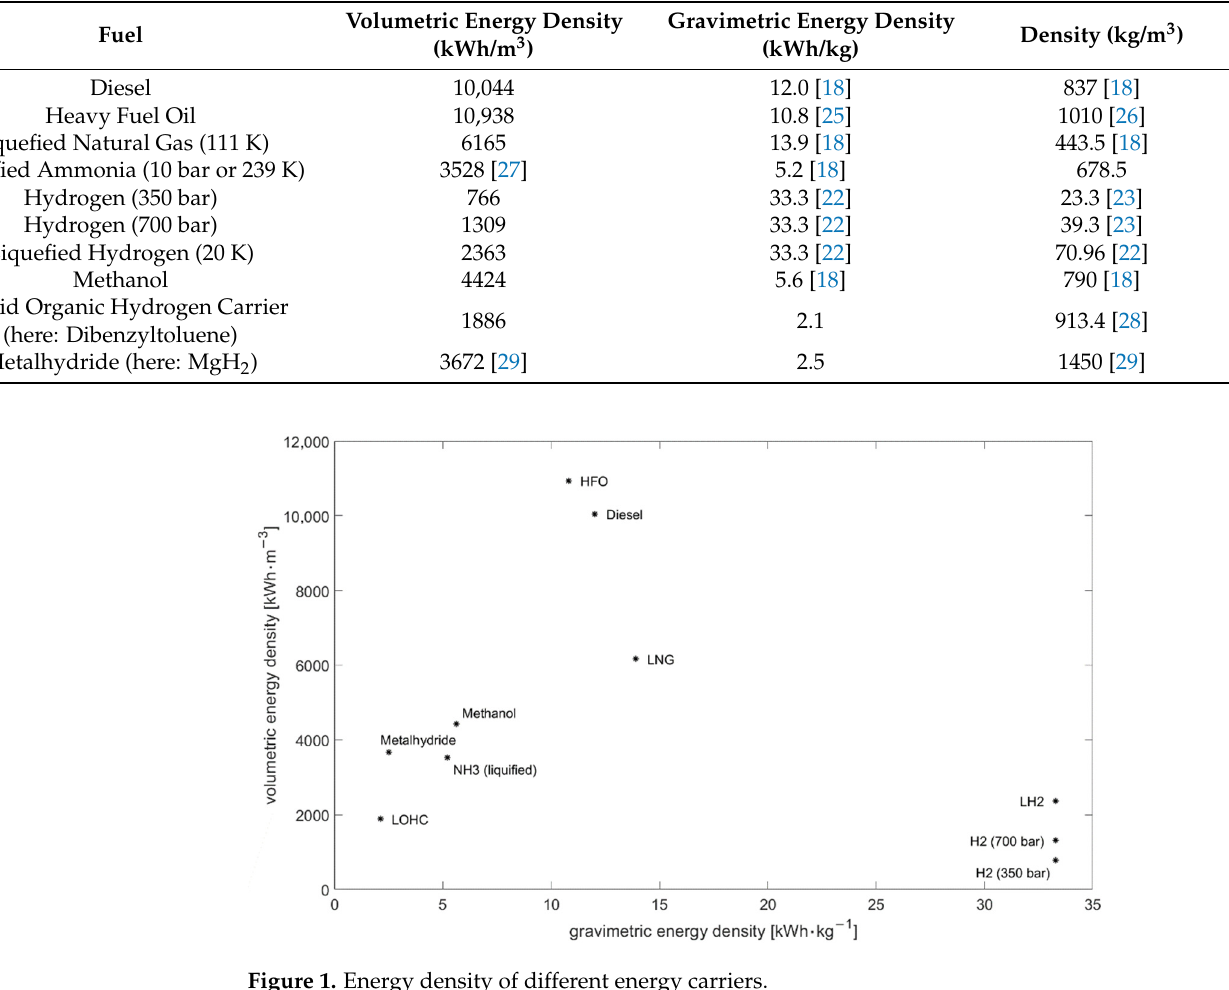
Figure 1. Energy density of different energy carriers.